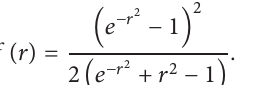
Figure 4: Solutions to 𝜀